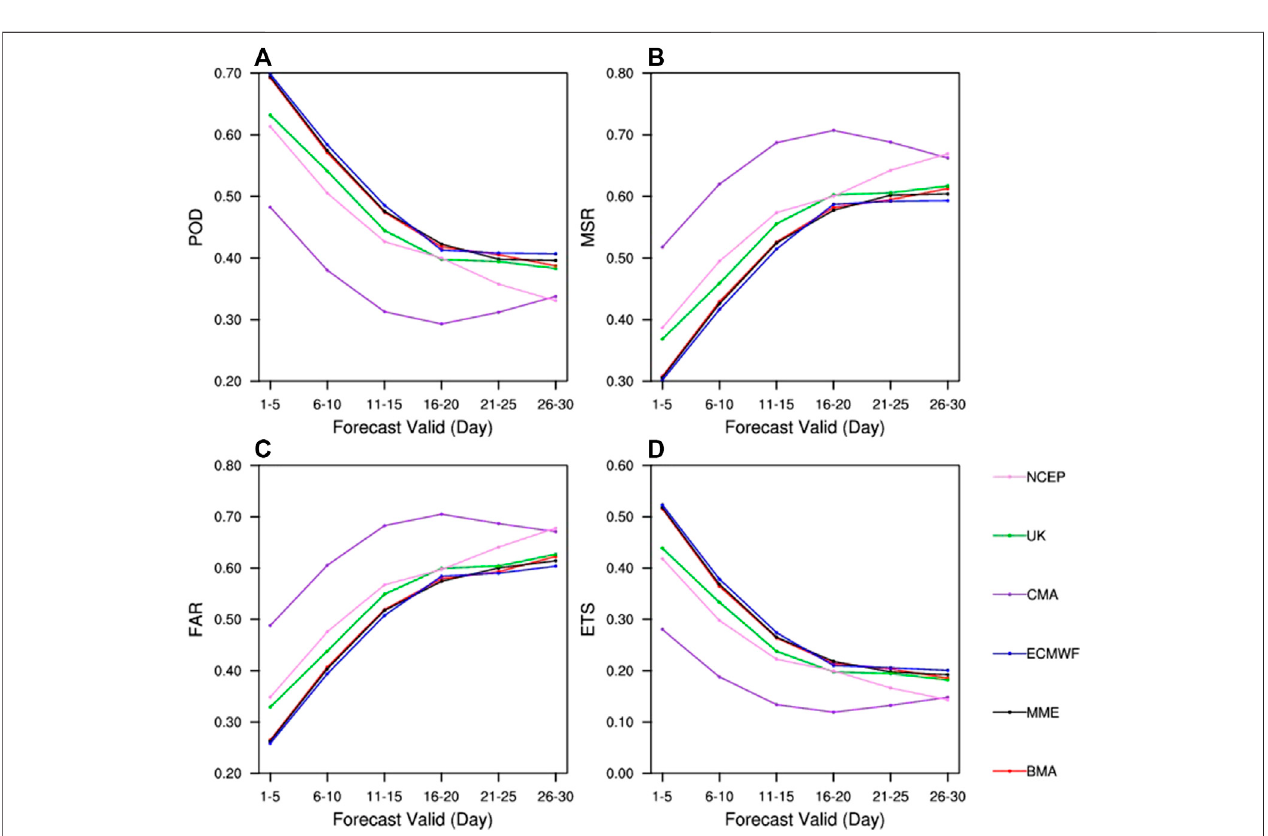
FIGURE 9 | The POD (A) , MSR (B) , FAR (C) , and ETS (D) as a function of forecast lead days for different reforecasts of heatwaves.